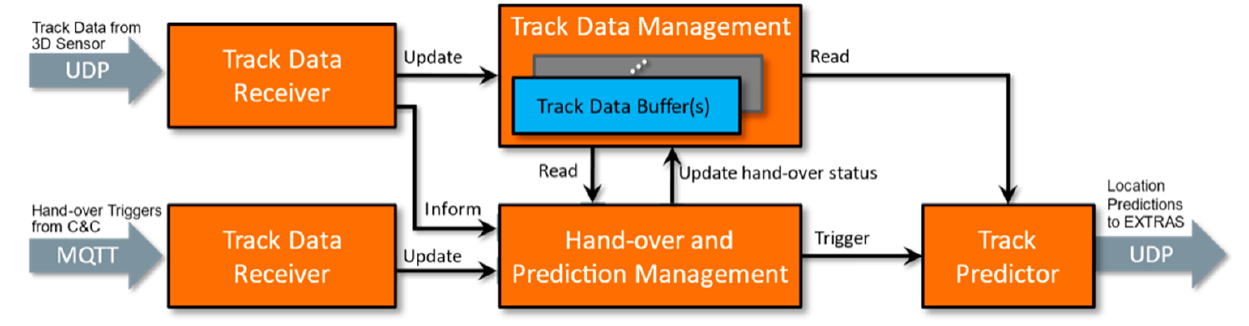
Figure 3. 3D Video software architecture.